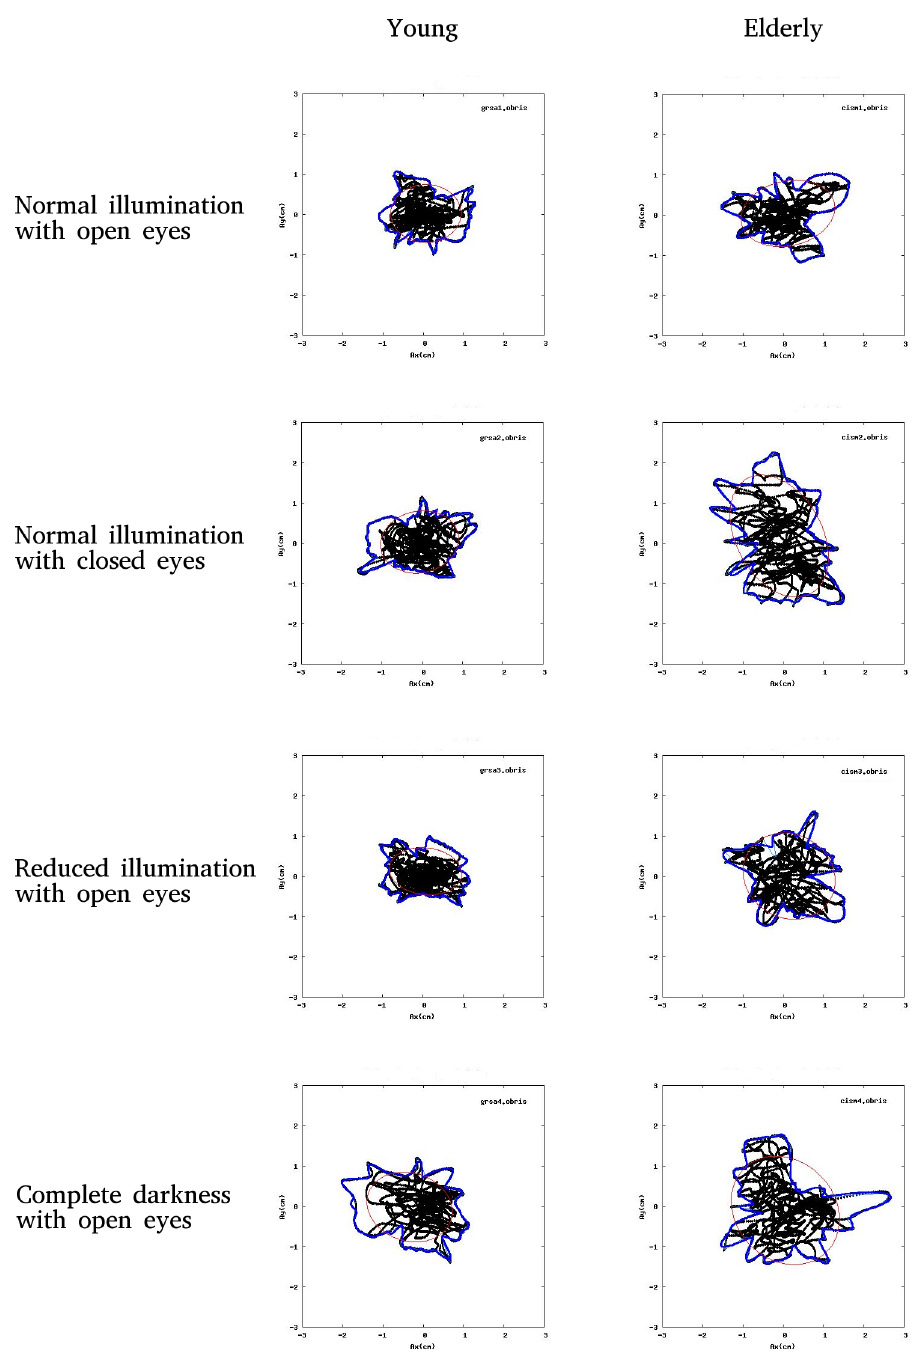
Figure 1. Typical CoP movement recordings. Typical CoP movement recordings from a young and an elderly participant under the four experimental conditions. The CoP path is indicated by the black dotted line, the CoP outline is indicated in blue, and the elliptic PCA region with 95% points along each axis is delineated by the red line.